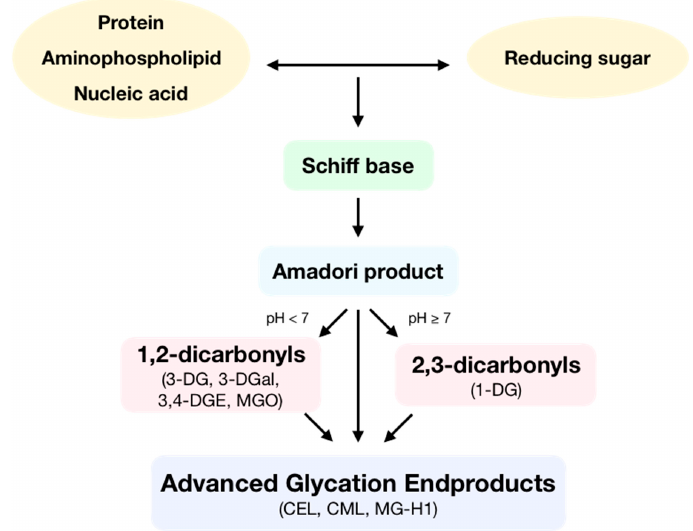
Figure 1. Formation of advanced glycation endproducts (AGEs). During the Maillard reaction, the free amino group of a protein, aminophospholipid, or nucleic acid reacts with the carbonyl group of a reducing sugar, producing a Schi ff base. This molecule, following some rearrangement, is spontaneously transformed into an Amadori product. Depending on pH, these products form 1,2-dicarbonyls as 3-deoxyglucosone (3-DG), 3-deoxygalactosone (3-DGal), or methylglyoxal (MGO) or form 2,3-dicarbonyls such as 1-deoxyglucosone (1-DG). Then, dicarbonyls following condensation produce AGEs such as N ε -(carboxyethyl)lysine (CEL), N ε -(carboxymethyl)lysine (CML) or methylglyoxal-derived hydroimidazolone 1